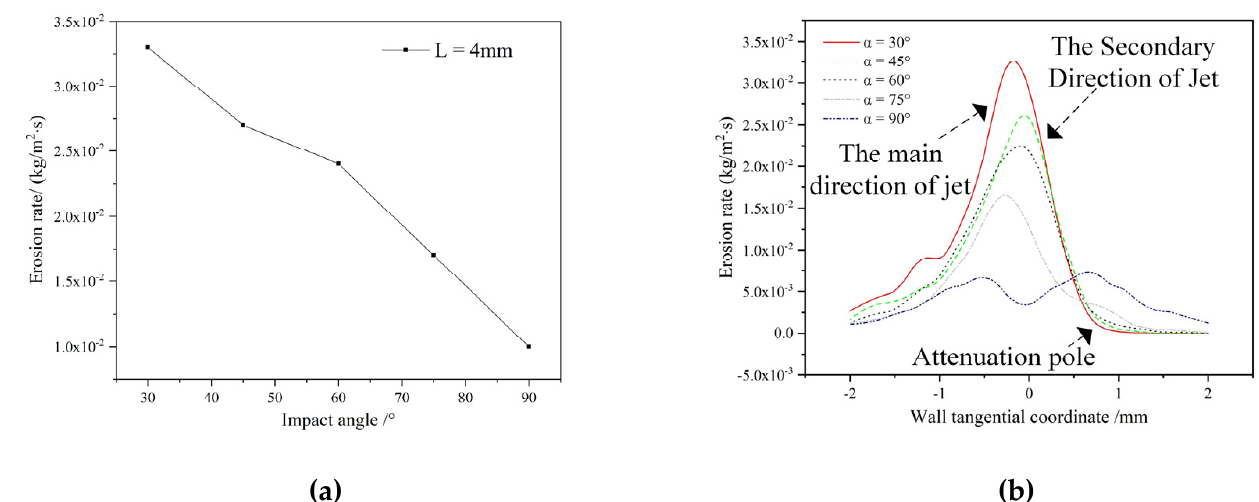
Figure 11. Simulation of workpiece wall removal under different impact distances. Influence curve of erosion rate ( a ). Wall erosion rate ( b ).